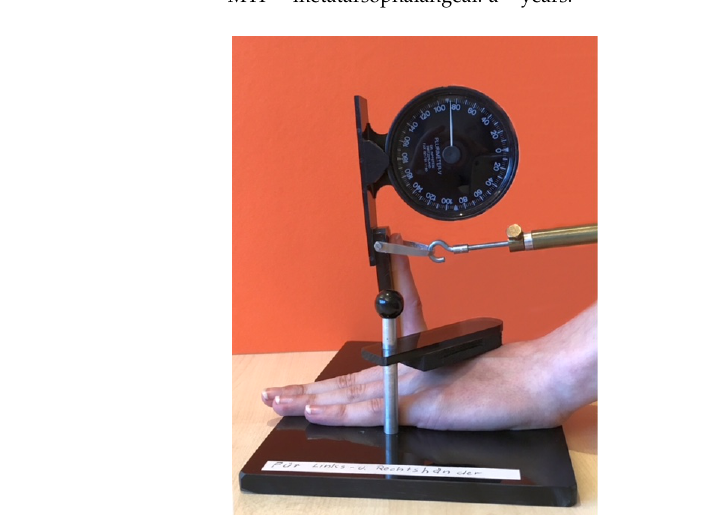
Figure 1. Non-dominant hand on plate of Pluri-Ligament with index finger pulled into dorsiflexion with 1 kg of pulling force (figure with the kind permission of Thieme group, © Thieme).